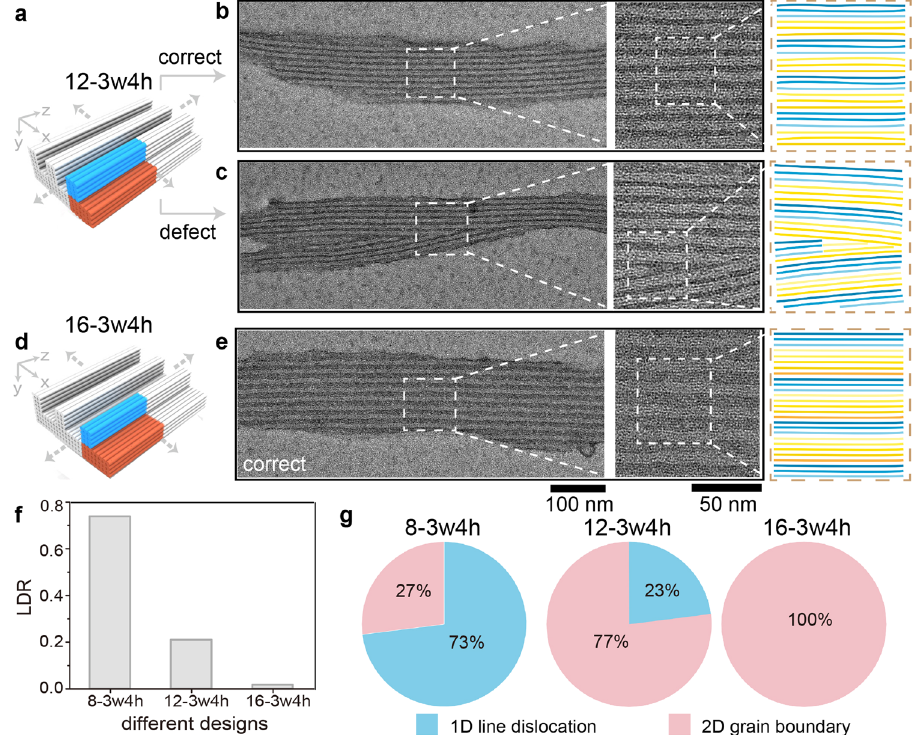
Fig. 2 Crystallographic defects at different line pitches. Design schematic ( a ) and assembly morphologies (correctly assembled lines in b , pattern defects in c ) for the representative DNA line arrays (12-3w4h) with 11.5-nm line pitch along x direction. Design schematic ( d ) and assembly morphology (correctly assembled lines in e ) for the representative DNA line arrays (16-3w4h) with 15.3-nm line pitch along x direction. Because the pattern defects are rare at 15.3-nm pitches, they are not considered as the representative assembly morphologies. In b , c , and e , zoomed-out (left), zoomed-in (center) TEM images, and the line schematics (right) along the x-z projection plane. The scale bars are 100 nm (left) and 50 nm (center). LDR values ( f ) and the compositions of the high-dimensional pattern defects ( g ) for DNA line arrays of 8-3w4h, 12-3w4h, and 16-3w4h. The ratios between 1D line dislocation and 2D grain boundary in g are counted from more than 30 independent defective DNA brick crystals in each design. Enlarging the line pitches changes the compositions of the high-dimensional pattern defects, from 1D line dislocation as the major defect (73%) to the dominating 2D grain boundary (i.e.,